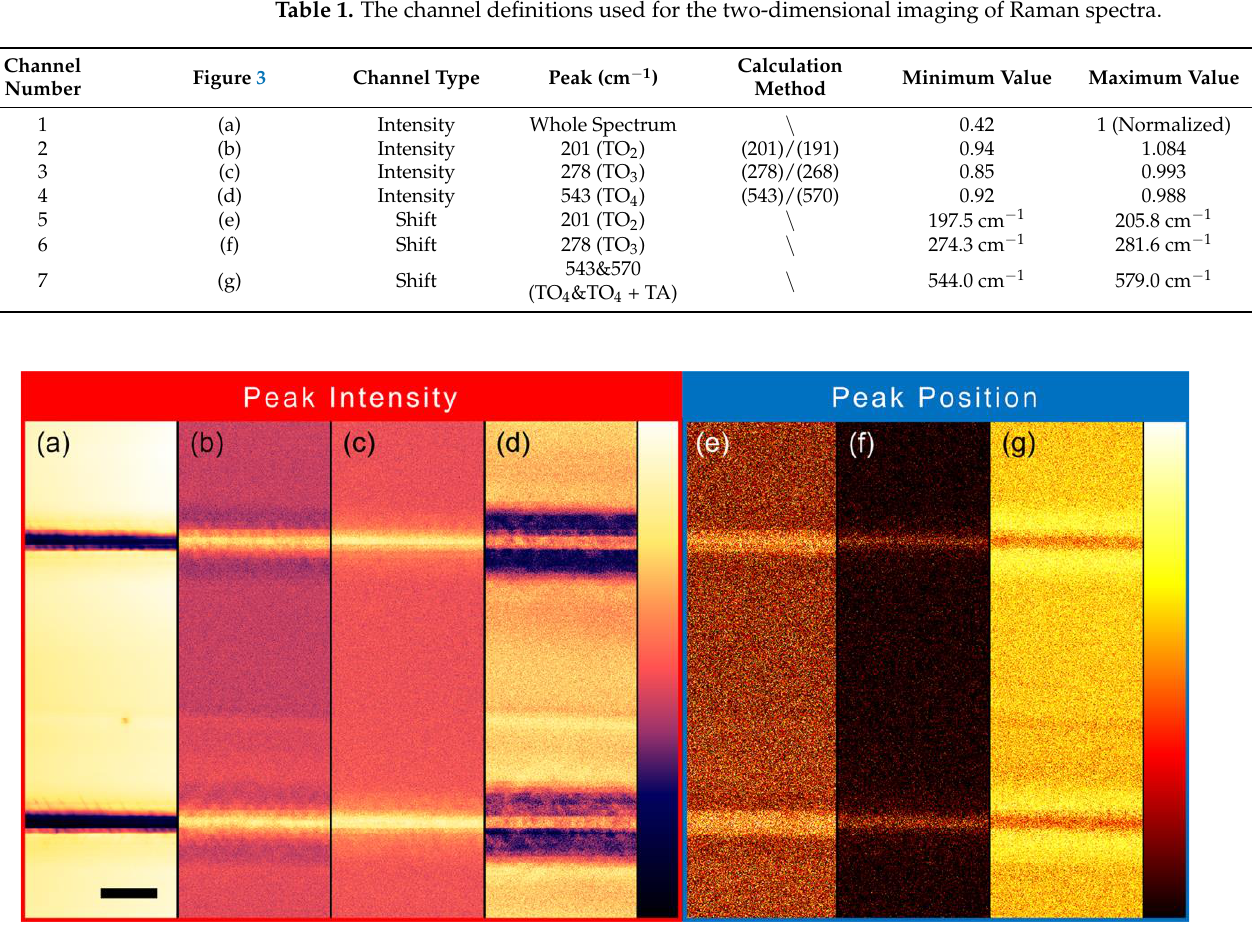
Figure 3. Two-dimensional spatial distributions of the Raman spectra representing ( a – d ) peak intensities and ( e – g ) peak positions obtained at room temperature. Channel details can be found in Table 1. The scale bar is 10 μm. Table 1. The channel definitions used for the two-dimensional imaging of Raman spectra.